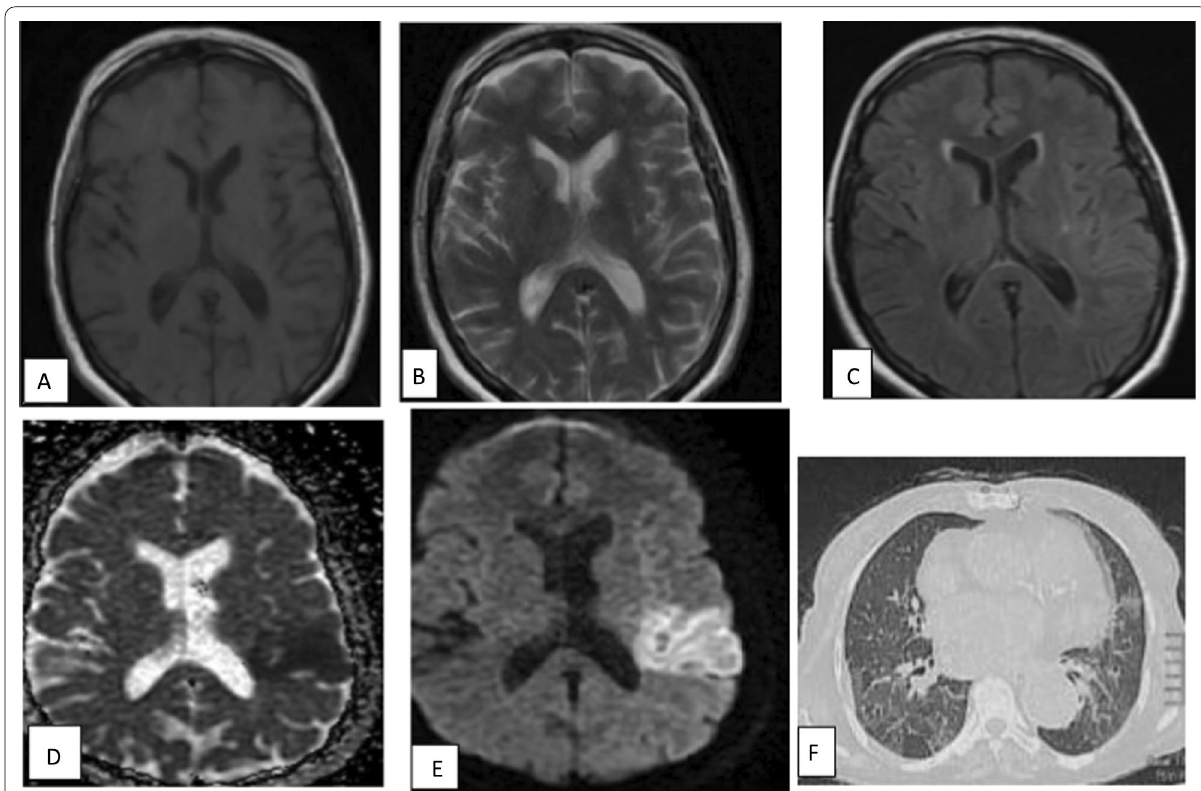
Fig. 3 A 50-year-old male patient presented with cerebrovascular stroke post COVID. MRI a axial T1WI, b axial T2WI, c axial FLAIR revealed no abnormality. d ADC map, e DWI revealed a well-defined area of restricted left parietal region acute infarction. f CT chest at admission showing CORAD III (mosaic CT attenuation). CT chest during acute phase is not